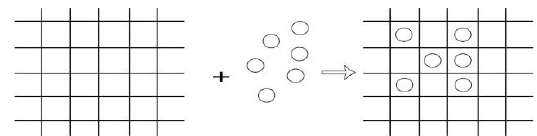
Figure 1. Schematic picture of a